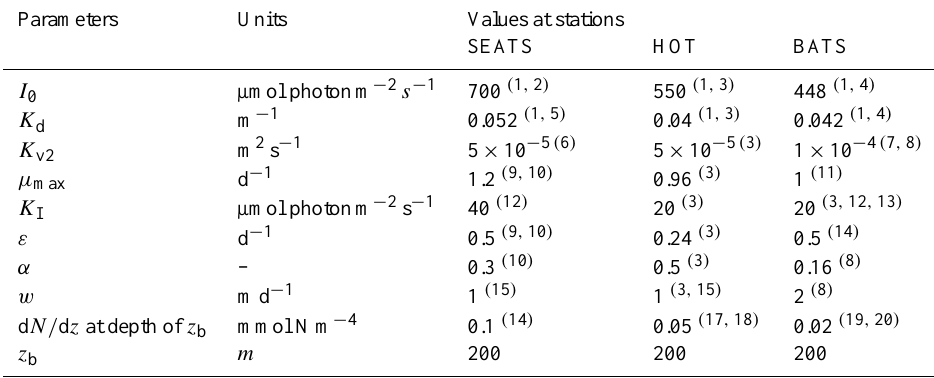
Table 2. Parameter values at SEATS, HOT, and BATS. Parameters Units Values at stations